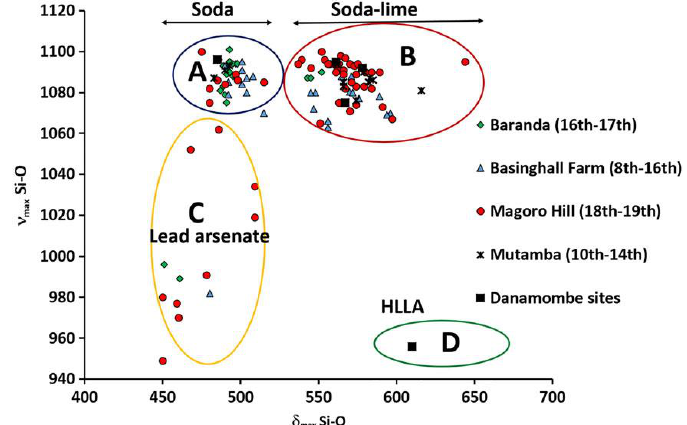
Figure 9. Representation of the relationship between the bending and stretching vibration bands of the SiO 4 network. Points are classified in four groups with different composition. (Reproduced from SiO 4 network. Points are classified in four groups with di ff erent composition. (Reproduced from work work in [40] with the permission of Wiley, copyright 2019.) in [40] with the permission of Wiley, copyright